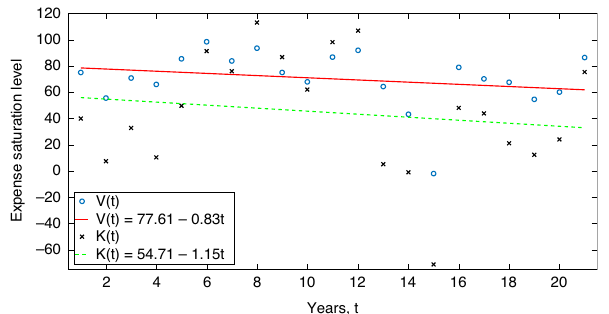
Fig. 6 Engel parameter dynamics. V ( t ) (solid line) and K ( t ) (dotted line) of the dimensionally reduced model versus time t . As shown in the fi gure, the regression fi t functions are given by V ( t ) = 77.61 − 0.83 t and K ( t ) = 54.71 − 1.15 t . The regression fi ts justify the fi rst-order linearity approximations of V ( t ) and K ( t ) as functions of time t .